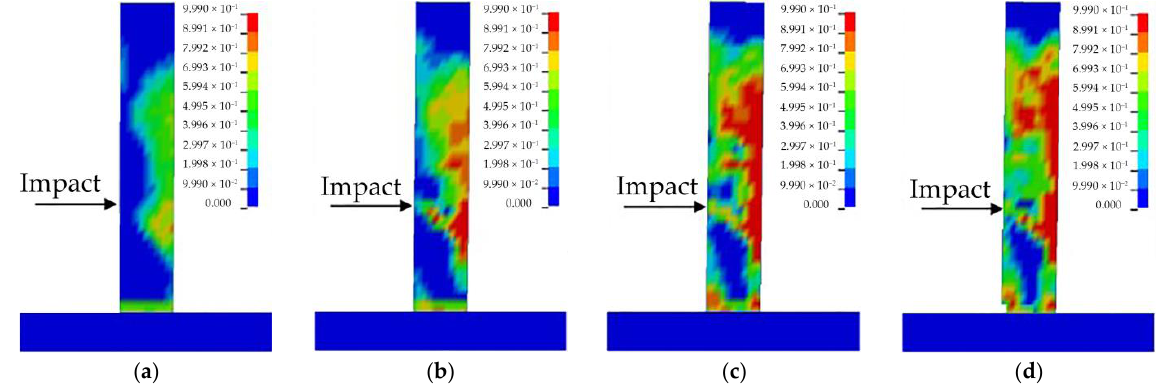
Figure 17. Comparison of damage at different impact speeds: ( a ) v = 2.425 m/s; ( b ) v = 3.960 m/s; ( c ) v = 5.422 m/s; ( d ) v = 6.260 m/s.